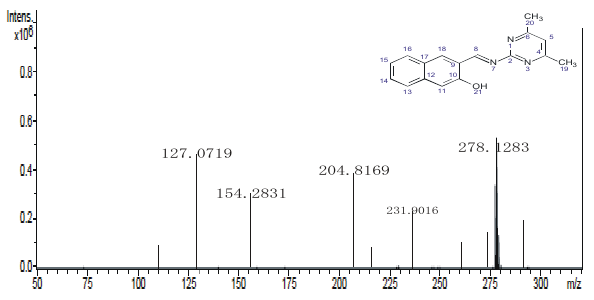
Figure 2 : Enlarged Mass Spectrum of 3-{( E )-[(4,6-dimethylpyrimidin-2-yl)imino]methyl} naphthalen-2-ol (See SM2 ).